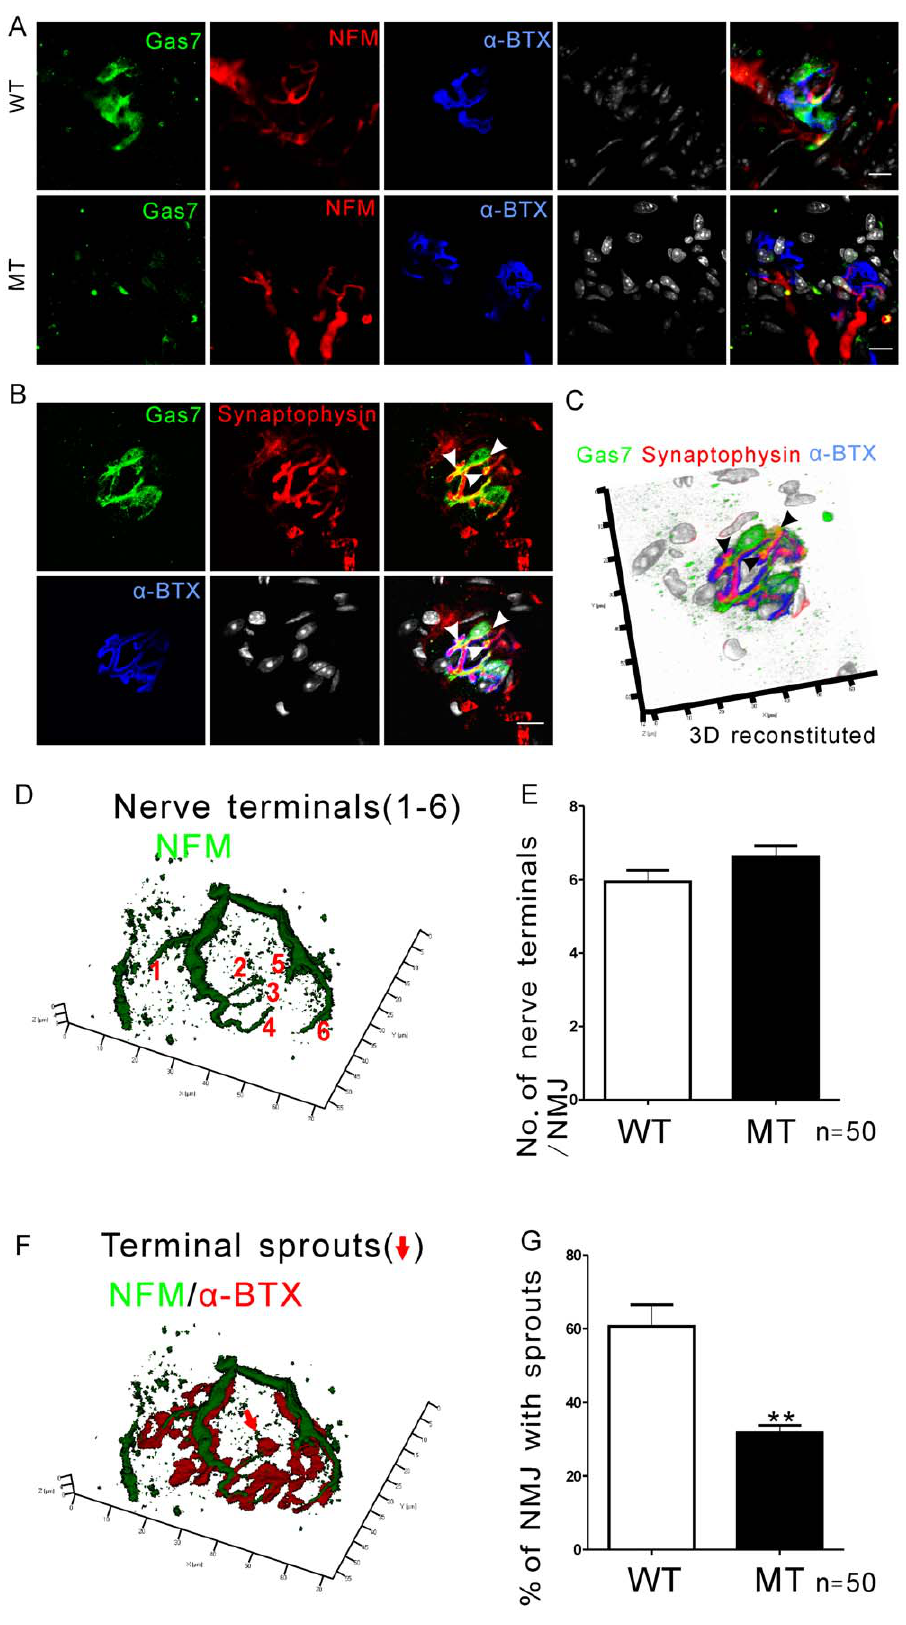
Figure 6. Gas7 localizes at the presynaptic region of the NMJ and is associated with axon terminal sprouting. (A) Gas7 aggregates at the axon terminal region of NMJ in wild-type (WT) soleus. Only weak Gas7 expression was detected in the NMJs of the soleus from the Gas7-deficient